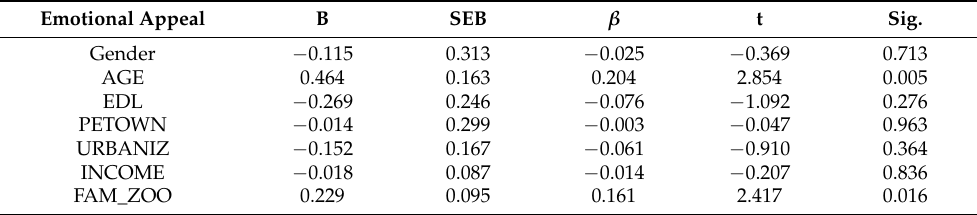
Table 8. Results of the multiple regressions applied to predict differences in emotional appeal (EMA) from gender, age, and education level (EDL), pet ownership (PETOWN), urbanization (URBANIZ), income level (INCOME), and zoo familiarity (FAM-ZOO). In the table the p -values < 0.05 indicate the corresponding variable is a statistically significant predictor of the outcome variable.